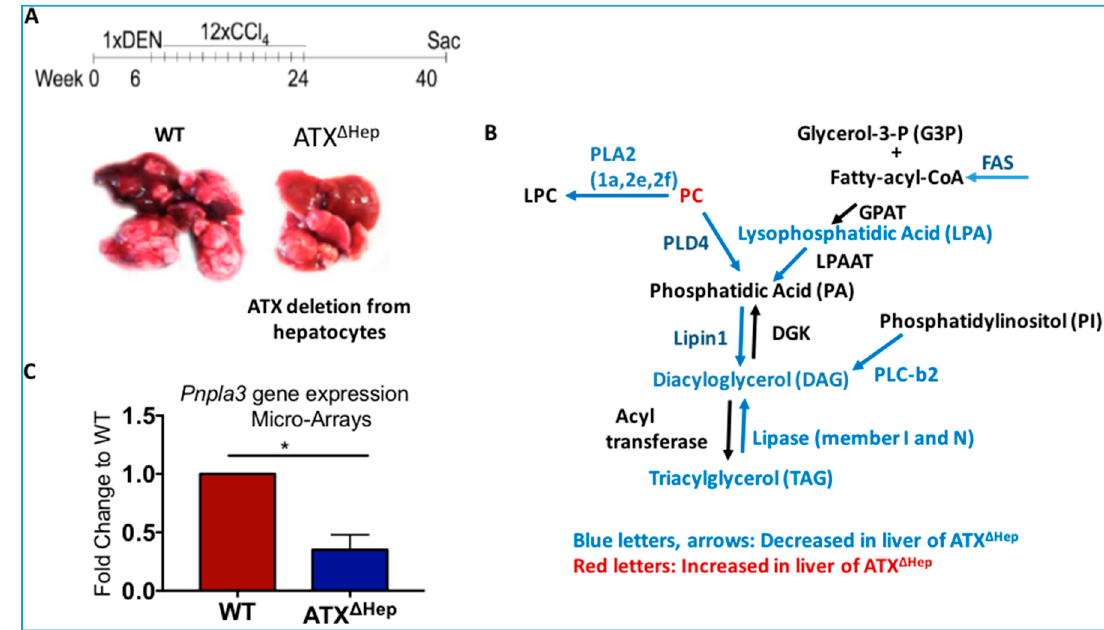
Figure 3. ATX genetic deletion from Hepatocytes (ATX ∆ Hep ) diminishes ( A ) tumor growth and ( B,C ) gene expression of key enzymes involved in lipogenesis compared to littermate WT mice. DGK: Diacylglycerol kinase; FAS: Fatty Acid Synthase; GPAT: Glycerol-3-phosphate acyltransferase; LPAAT: Lysophosphatidic acid acyltransferase; PLA2: Phospholipase A2; PLC: Phospholipase C; PLD: Phospholipase D. Results are from [152].